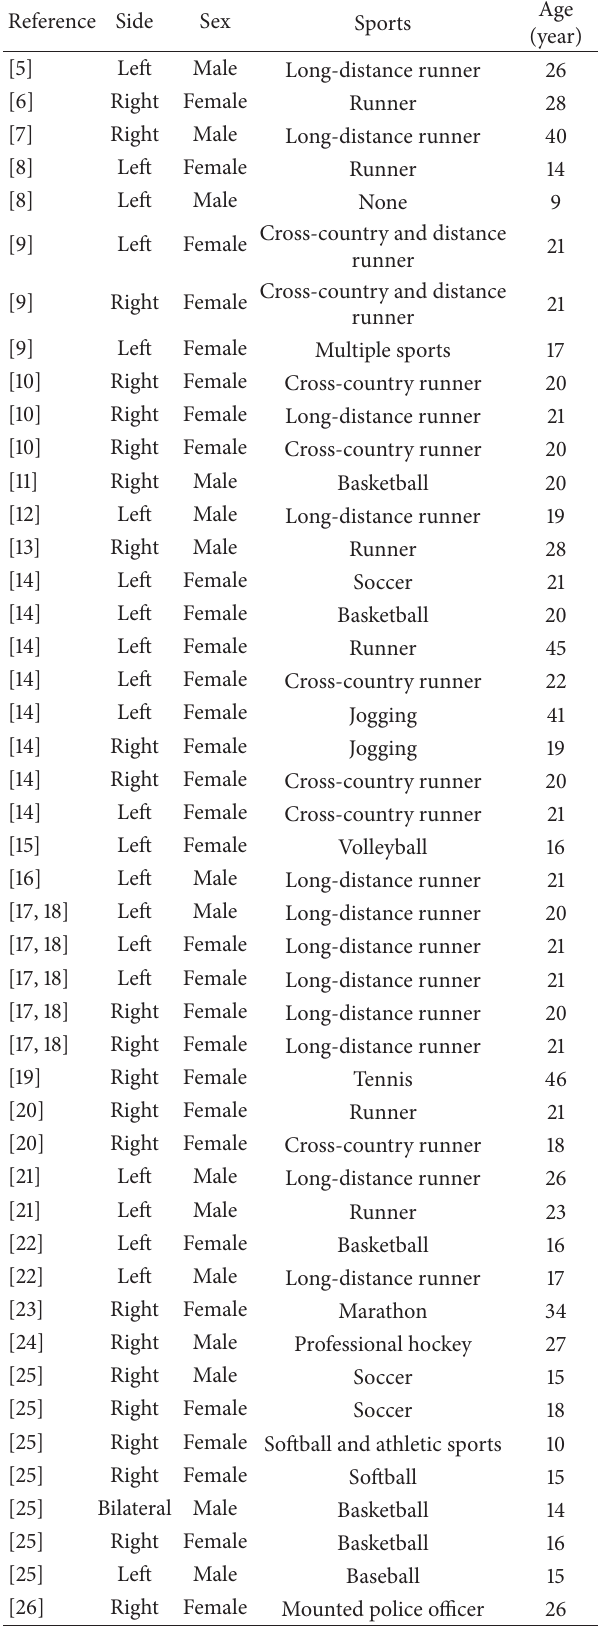
Table 2: Review of